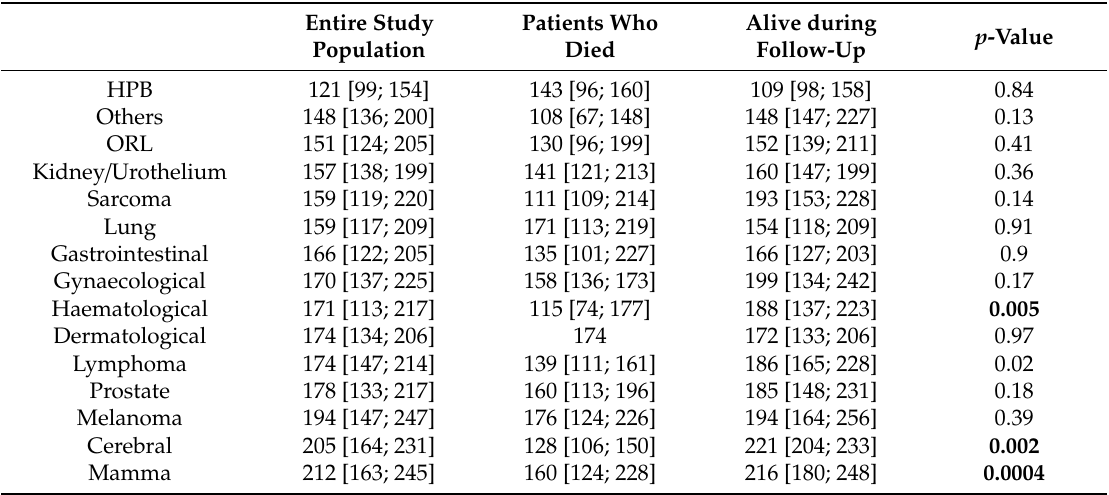
Table 2. Cholesterol levels based on di ff erent tumour entities. Values are presented as median